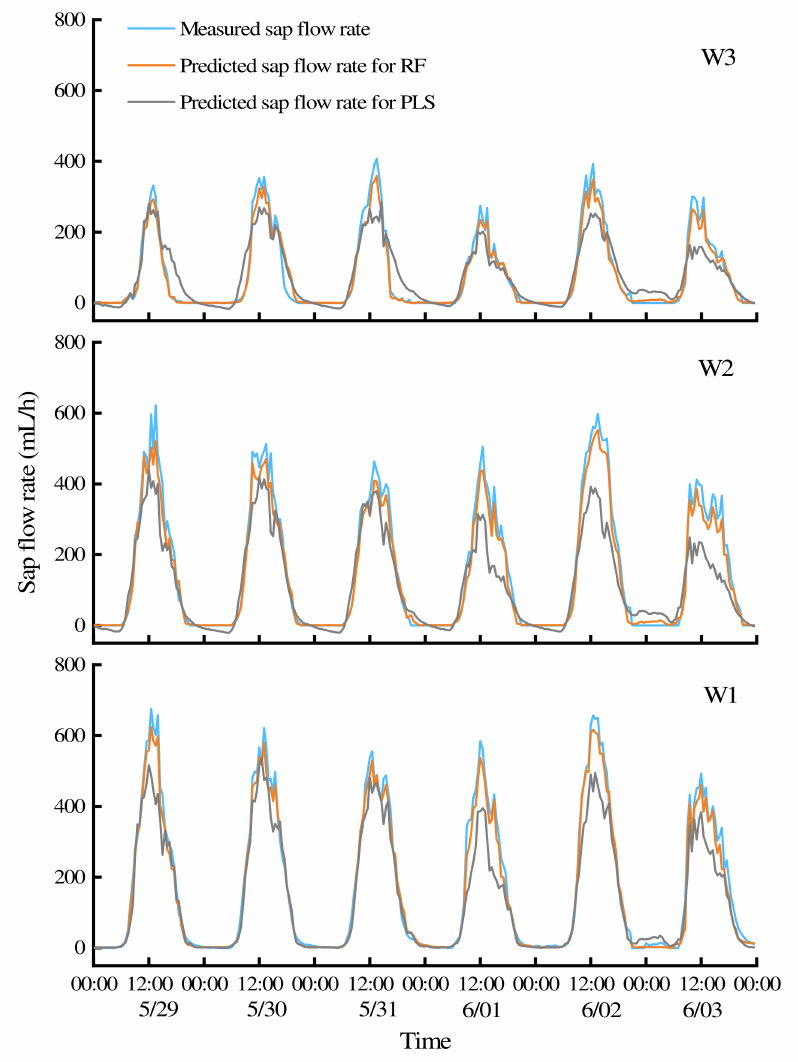
Figure 4. Comparison of trends in simulated and measured values during the fruit expansion